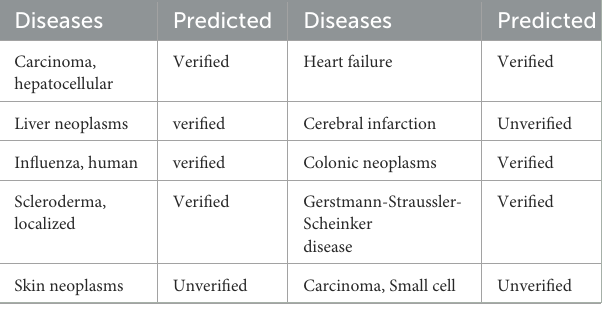
TABLE 3 A case study of the association of miRNA named hsa-mir-29a with various diseases. Diseases Predicted Diseases Carcinoma, hepatocellular